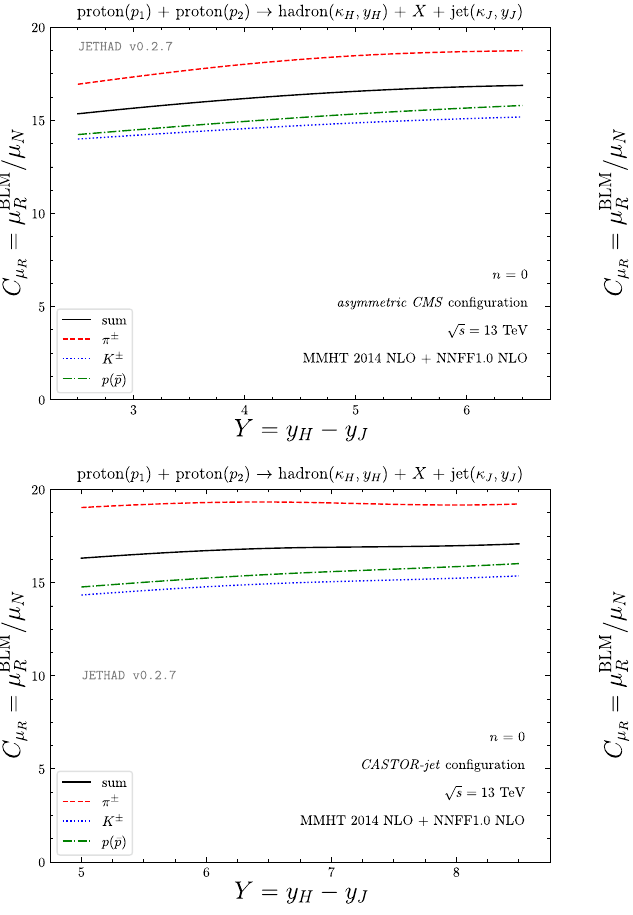
standard case, where the sum over all species is taken. Both the factor- ization scales, μ F 1 , 2 , have been set equal to μ BLM √ s = 13 TeV in the asymmetric CMS ( CASTOR-jet ) configuration for are given in upper (lower) panels